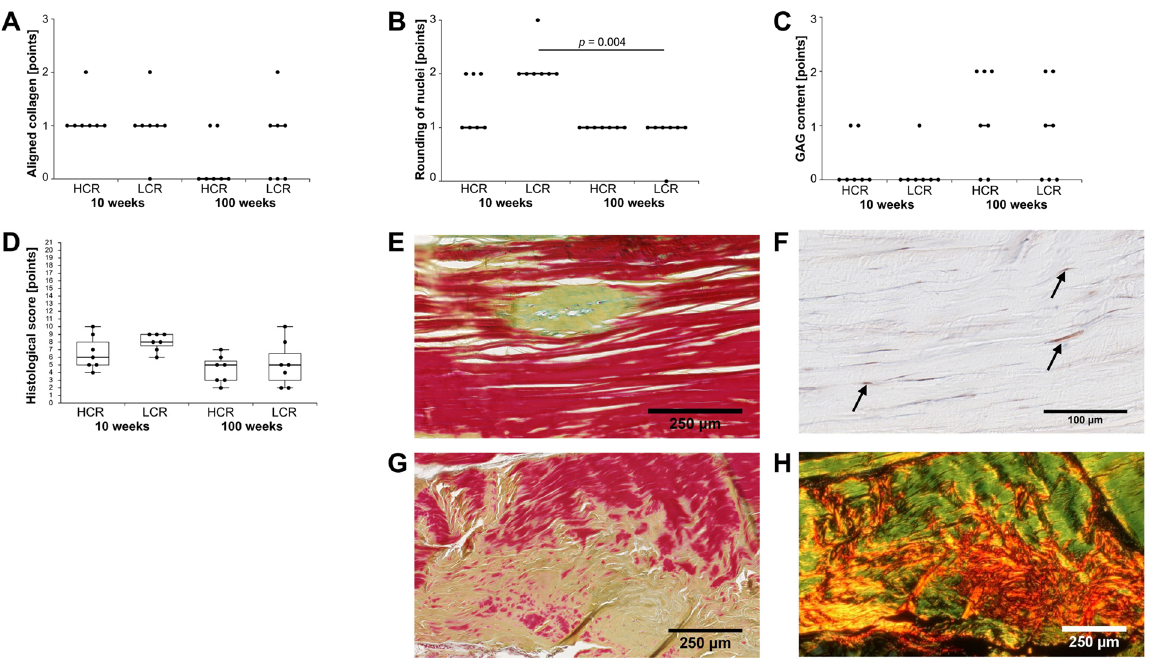
Figure 7. Semi-quantitative evaluation of ( A ) alignment of collagen, ( B ) rounding of tenocyte nuclei, and ( C ) GAG-content. Data are given as individual dot plots with median as a line in between the data points. ( D ) Total modified Movin score is given as a box plot with individual data points. Significant differences between two groups are marked as a line spanning between them with the p -value displayed above. p ≤ 0.05 was considered statistically significant. Exemplary images of histological evaluation show an ( E ) abnormal amount of the appearance of GAG in old rats (HCR 100 weeks, stained yellow-green in Movat Pentachrome (MP) staining, scale bar: 250 μ m) and ( F ) α SMA positive myofibroblasts (arrows) in young rats (HCR 10 weeks, stained red in α SMA staining, scale bar: 100 μ m). Disorientated collagen in the mid portion of the same tendon was also documented (LCR 10 weeks), stained in ( G ) Movat Pentachrome, scale bar: 250 μ m and ( H ) Picro Sirius Red with polarization microscopy, scale bar: 250 μ m.